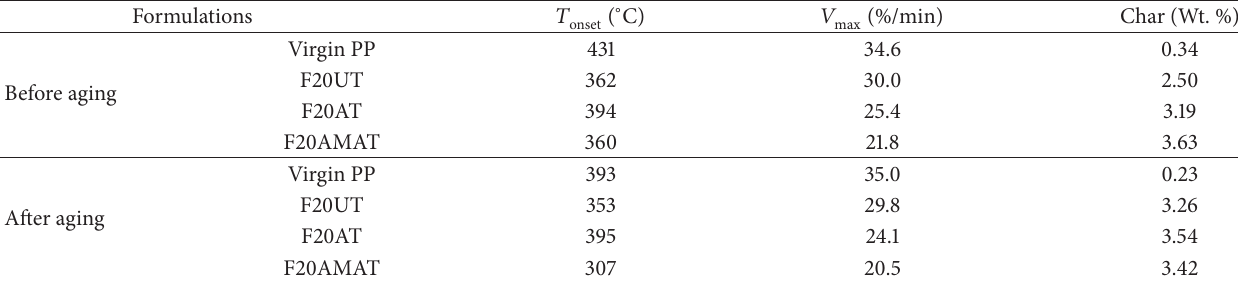
Table 2: TGA data for neat PP and PP/alfa fiber composite materials.